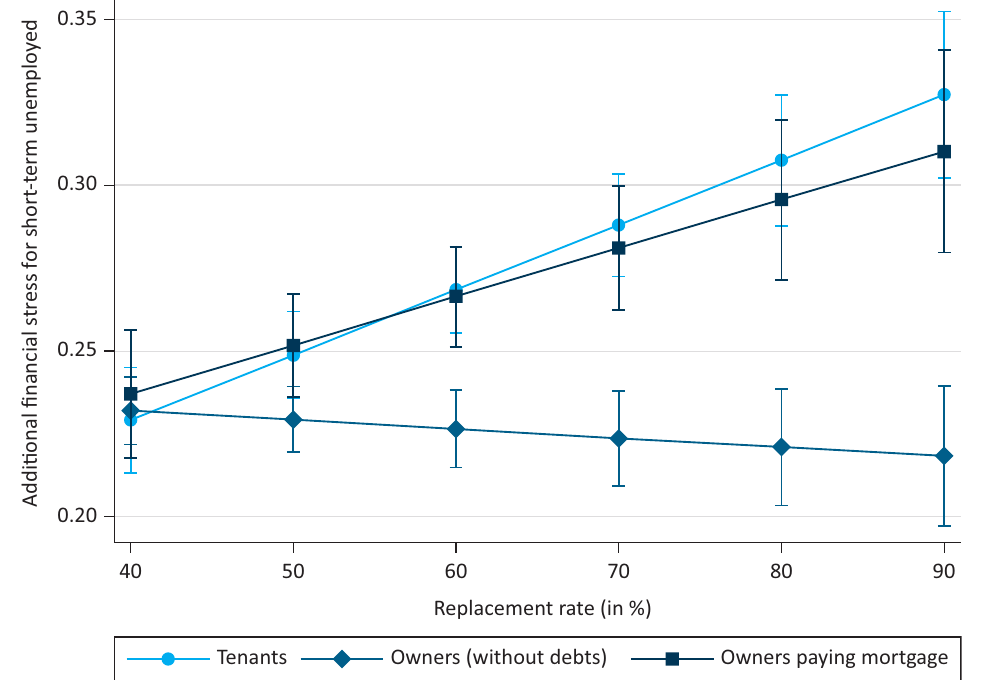
Figure 4. The additional financial stress of short‐term unemployment—as a function of the NRR and homeownership (2010–2018; 27 European countries; without controls for national context; based on Table 2, model 4). Source: Based on Eurostat